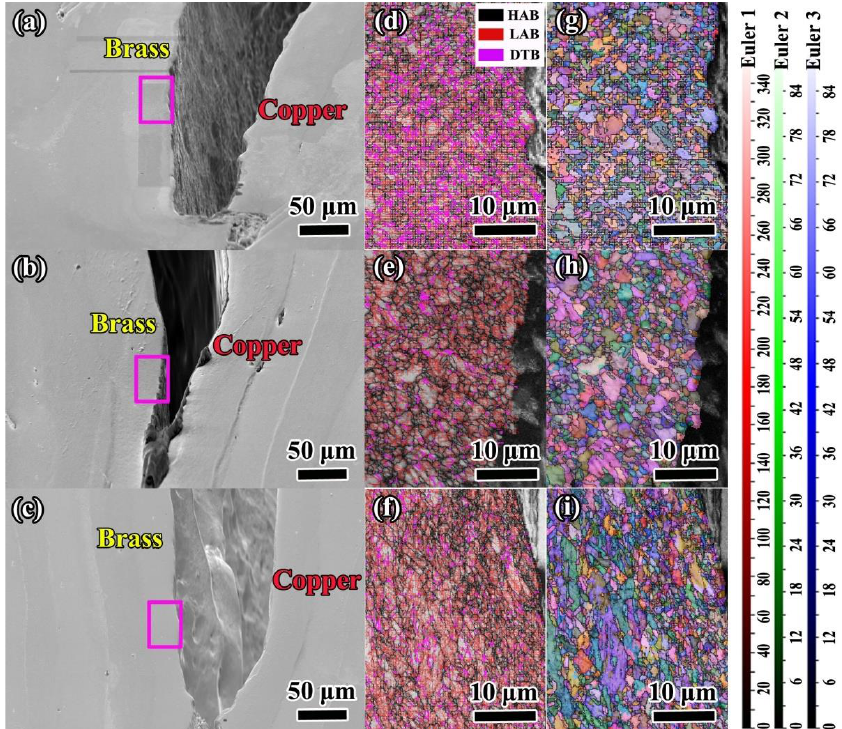
Figure 9. ( a – c ) The SEM images of delaminated copper – brass interfaces at LNT, RT, and 200 °C, respectively. ( d – f ) The distributions of LAGs, HAGs, and deformed twin boundaries (DTBs) of the selected regions in ( a – c ), respectively. ( g – i ) The Euler maps of the selected regions in ( a – c ), respectively.